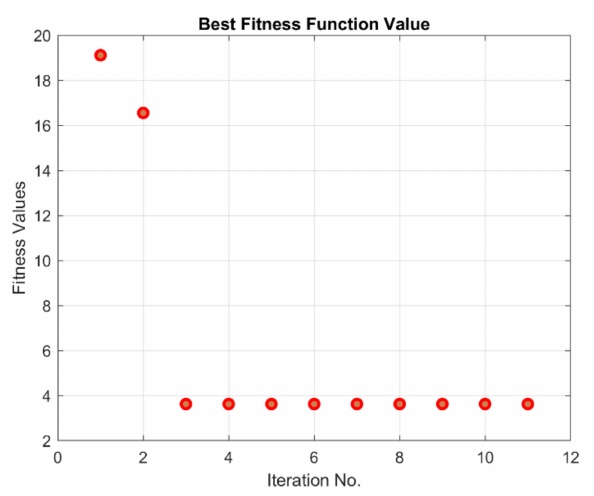
Figure 9. Best fitness value of Γ fuzzy rule